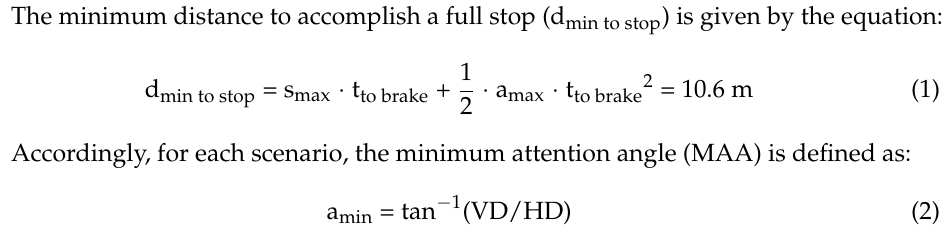
Accordingly, for each scenario, the minimum attention angle (MAA) is defined as: